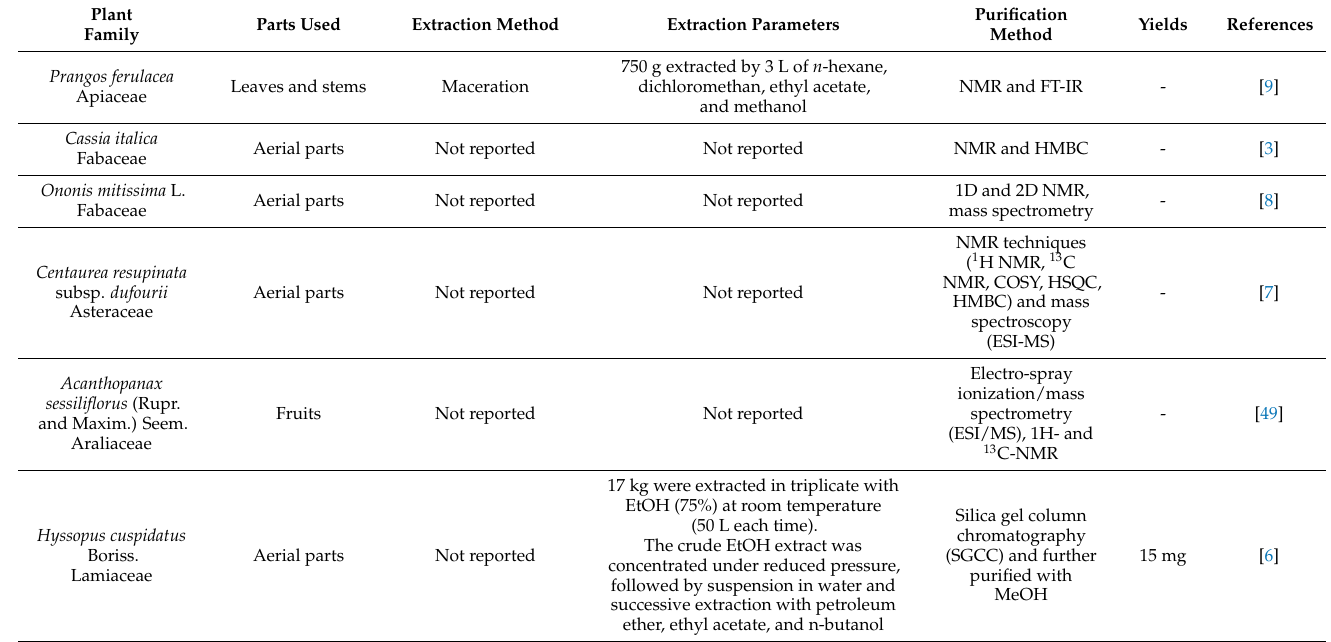
Table 2. Extraction and characterization of